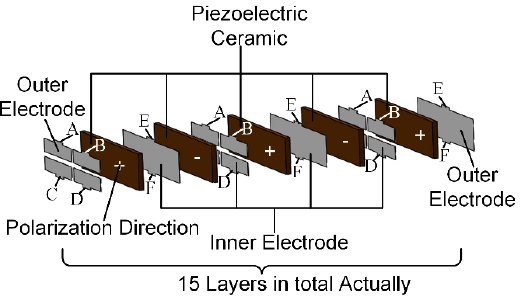
Figure 2. Schematic diagram for the assembly of electrode and piezoelectric ceramic layers, A, B, C, D, E and F stand for the fingers on the separate electrode portions.